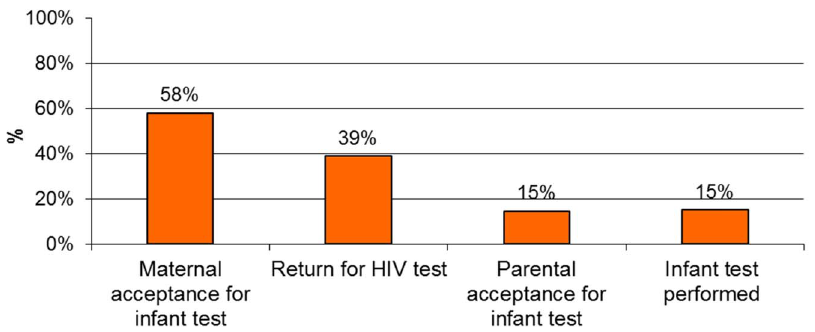
Figure 2. Rate of maternal acceptance and adequate parental acceptance for routine early infant HIV testing (N=3013). doi:10.1371/journal.pone.0067996.g002 PLOS ONE |